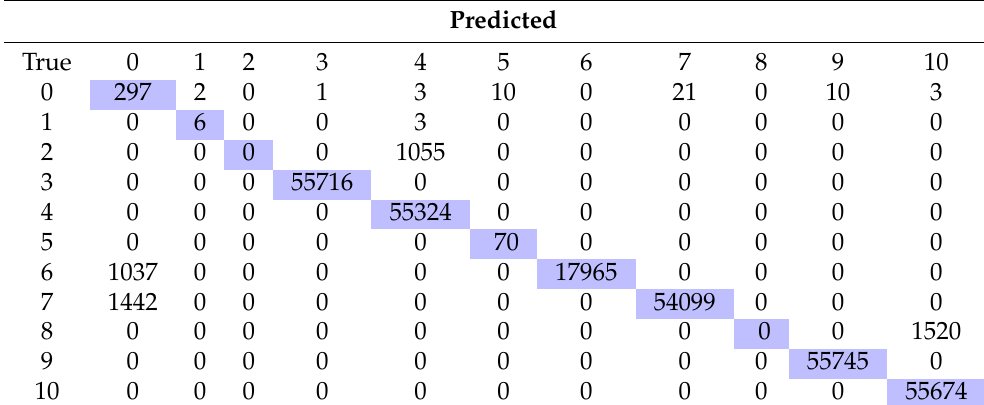
Table 46. DT weighted classes confusion matrix.